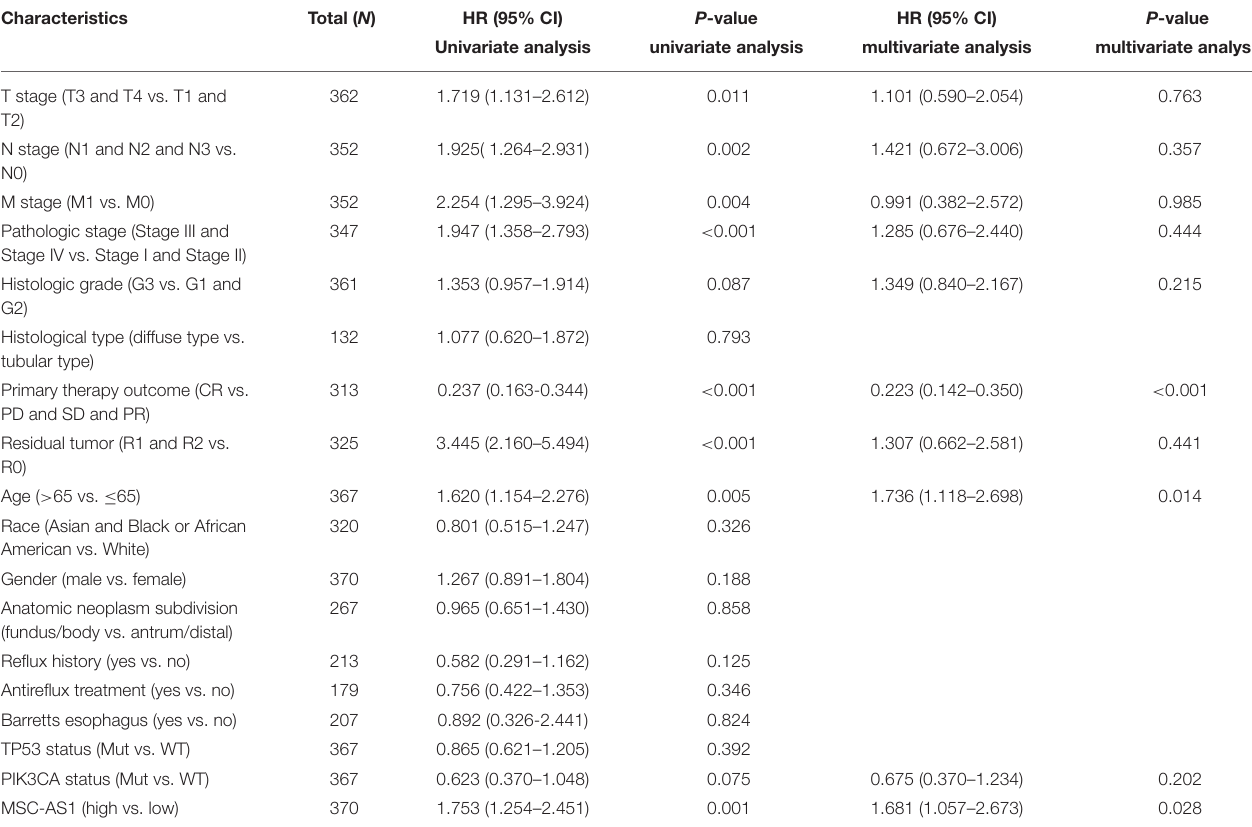
TABLE 3 | Associations between overall survival and clinicopathological characteristics in patients in TCGA using Cox regression.